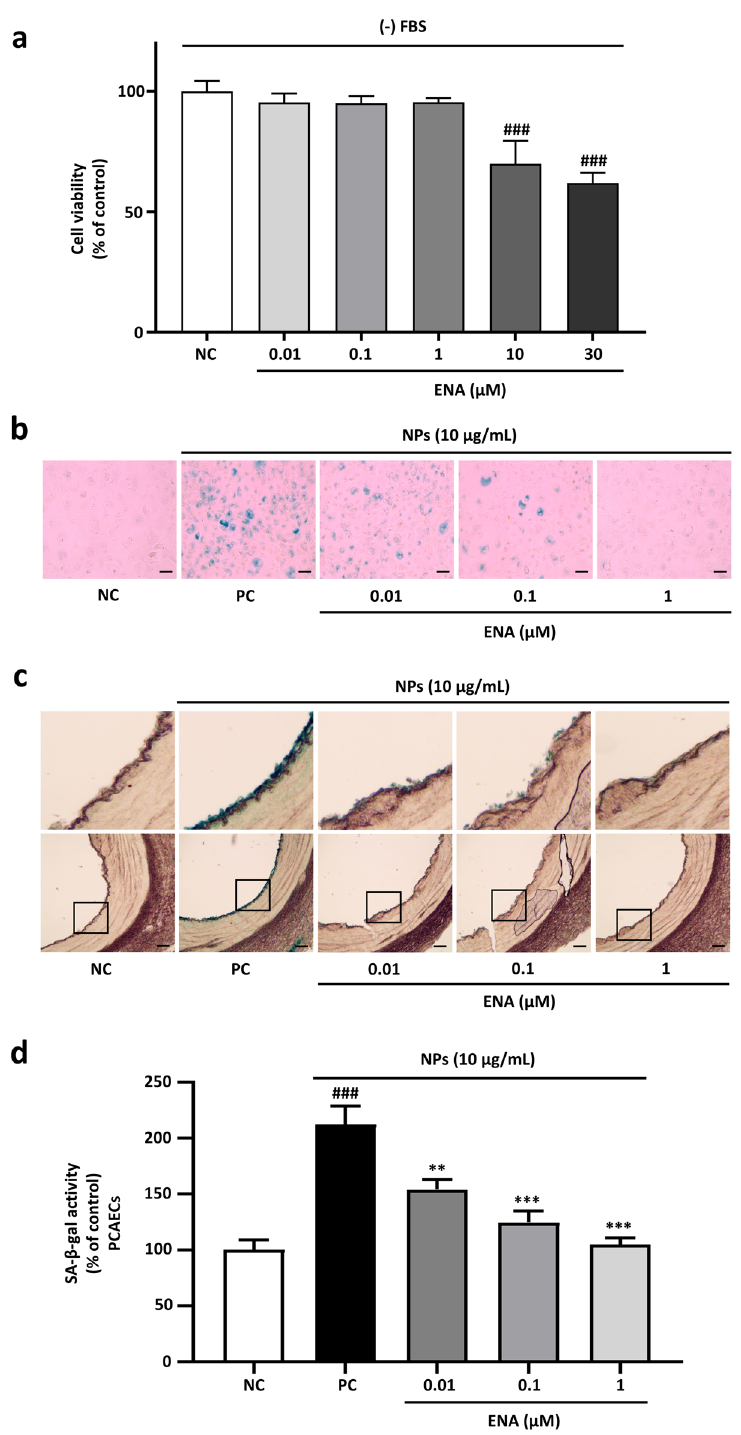
Figure 2. Inhibition of SGLT2 suppresses NPs-induced premature senescence in cultured and native ECs. ( a ) Cell viability of PCAECs with different doses of ENA. Data are the mean ± SEM (n = 6). ### p < 0.001 versus NC (complete media). ( b–c ) SA- β -gal activity was determined by X gal staining in PCA and PCAECs treated with or without NPs (10 μg/mL) alone or with ENA (0.01, 0.1, 1 μM) for 24 h. Representative staining images of PCAECs showing SA- β -gal (blue stain), and PCA rings, respectively; scale bar = 100 μM. ( d ) Cumulative SA ‐ β ‐ gal activity in PCAECs as a percentage of control. Results are expressed as mean ± SEM (n = 3–4). ** p < 0.01; *** p < 0.001 versus PC: positive control (complete media + NPs 10 μg/mL), ### p < 0.001 vs. NC (complete